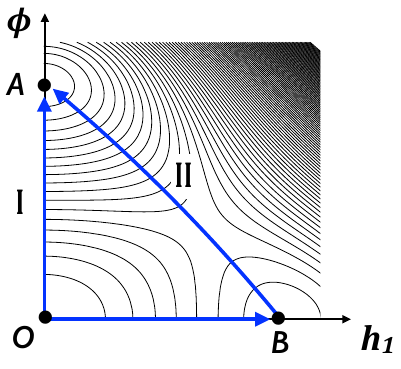
Figure 4 . Field trajectory I and II of the phase